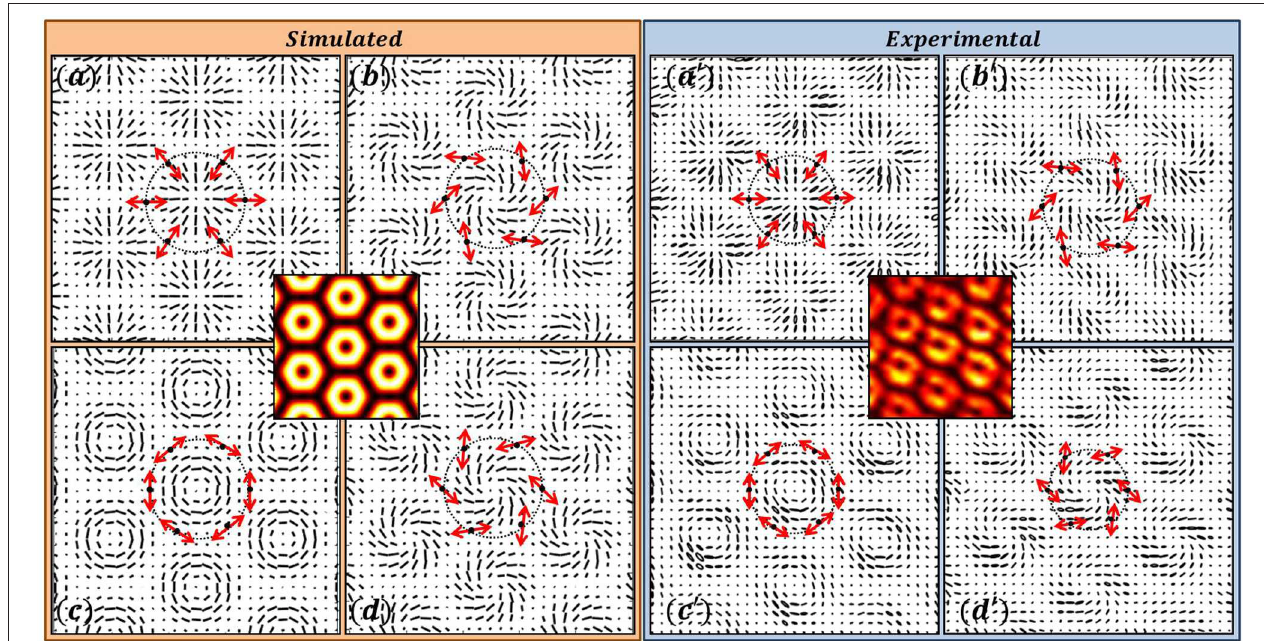
FIGURE 7 | Six Beam Interference producing lattice of V-points. The SOPs of the six plane waves are derived from a V-point with η = + 1. having radial, spiral, and azimuthal SOP distributions. Simulated results in (a–d) and experimental results in (a ′ –d ′ ) .